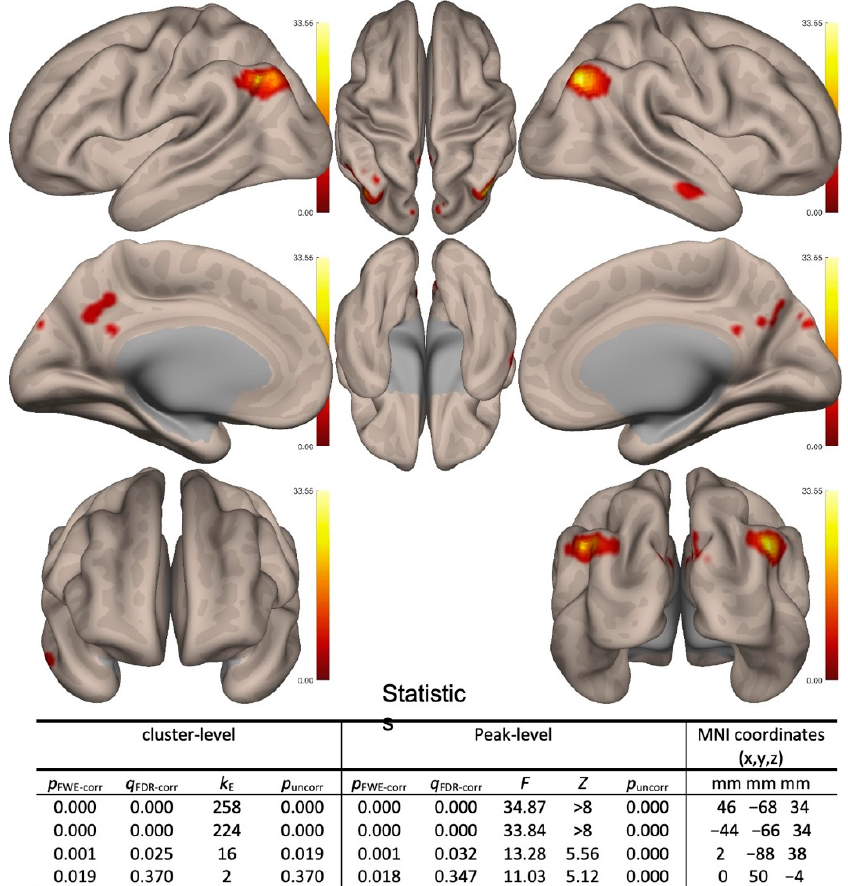
Figure 1. Between conditions (follow-up vs. baseline) and between subjects (cognitive stimulation therapy (CST) vs. treatment as usual (TAU)) second-level contrast maps with significant results. Positive contrasts (follow-up > baseline and CST > TAU) are shown in red colors. (Note: only default mode network (DMN) showed significant positive contrasts).